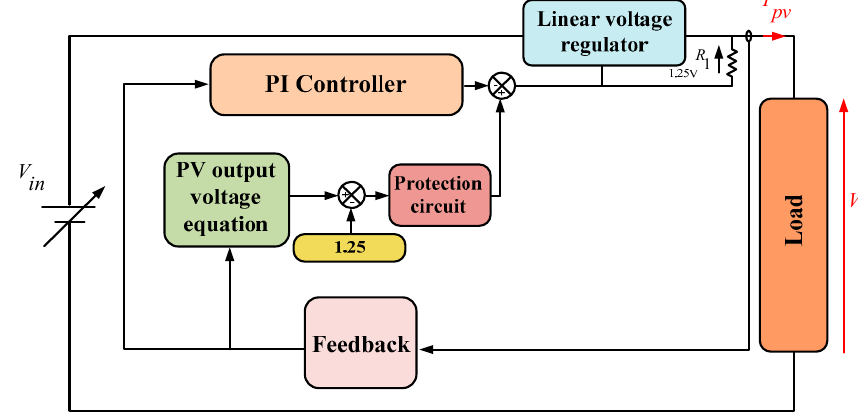
Figure 6. General structure of the proposed PV emulator.